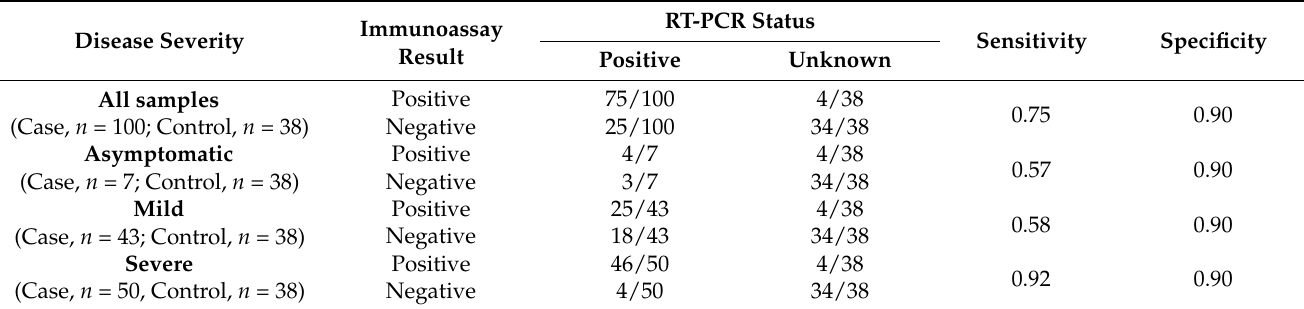
Table 3. Multi-ethnic cohort immunoassay data (Cohort